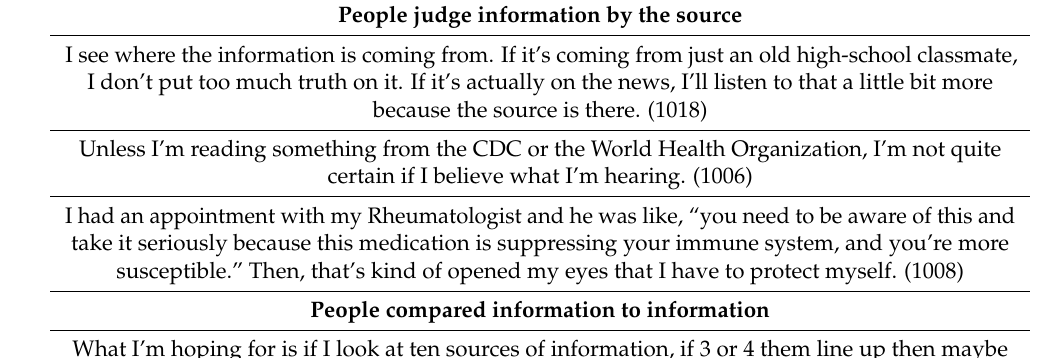
Table 2. Themes and quotes related to verifying information and judging its quality. People judge information by the